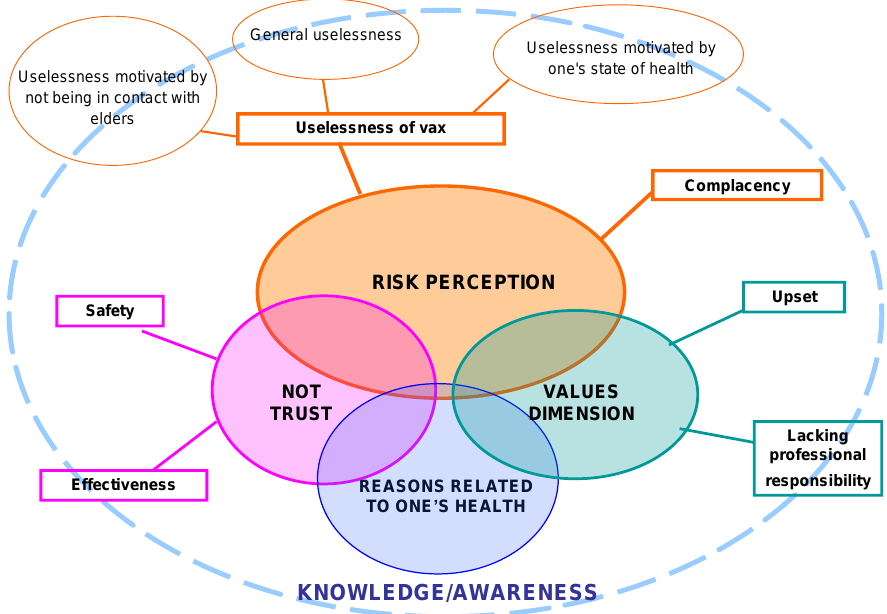
Figure 2. Links between macro-categories and sub-categories of reasons not to get vaccinated.